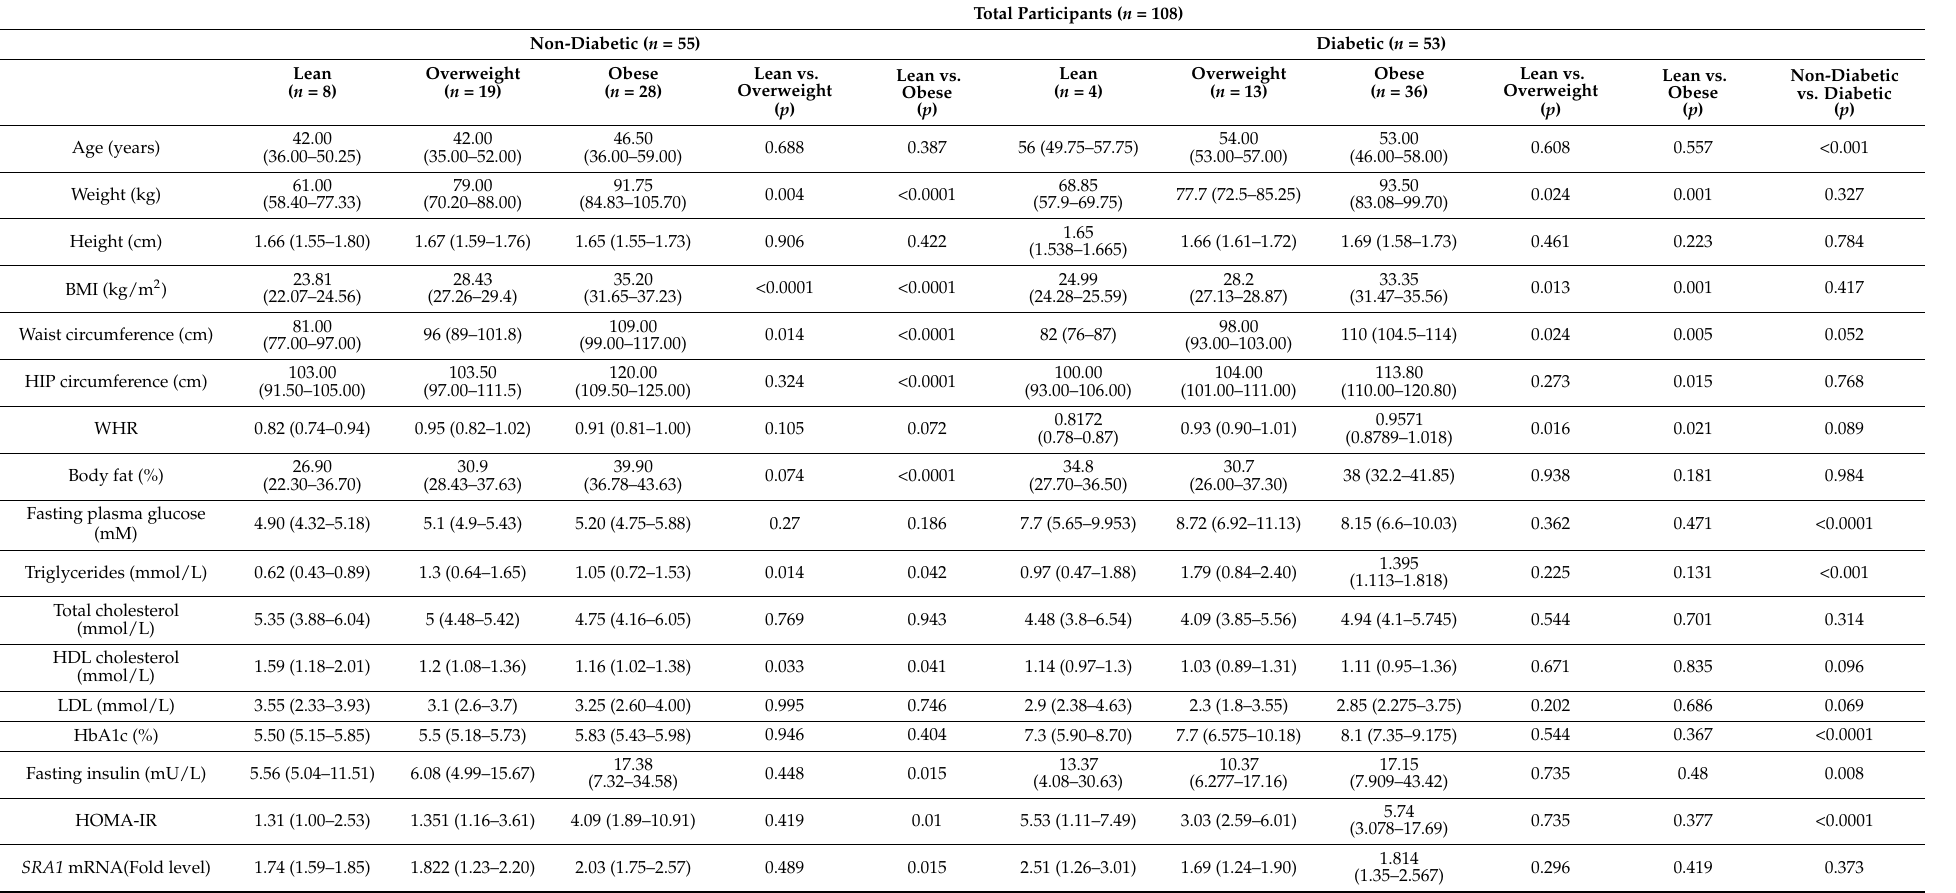
Table 2. Demographic and clinical characteristics of study